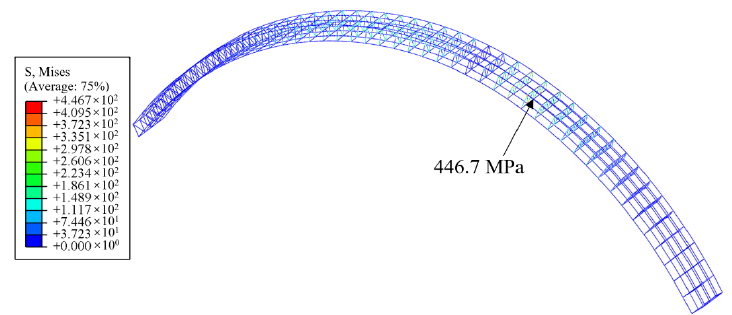
Figure 20. Mises stress nephogram of spatial reticulated grid.